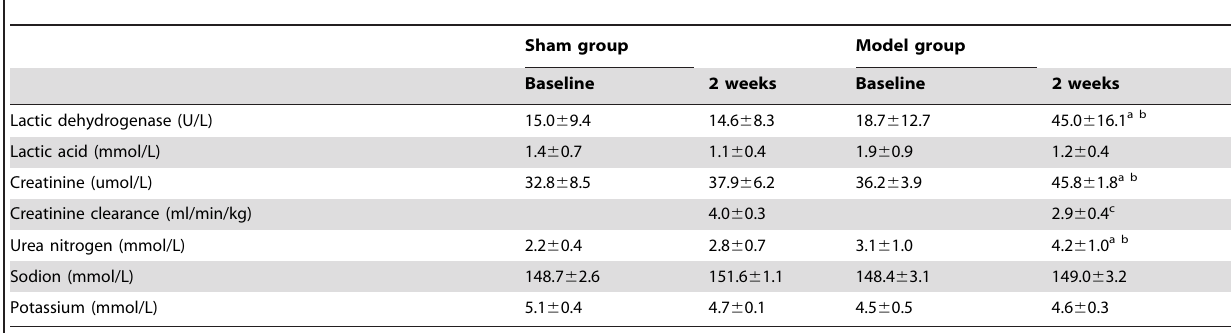
Table 1. Parameters associated with renal impairment and renal function.